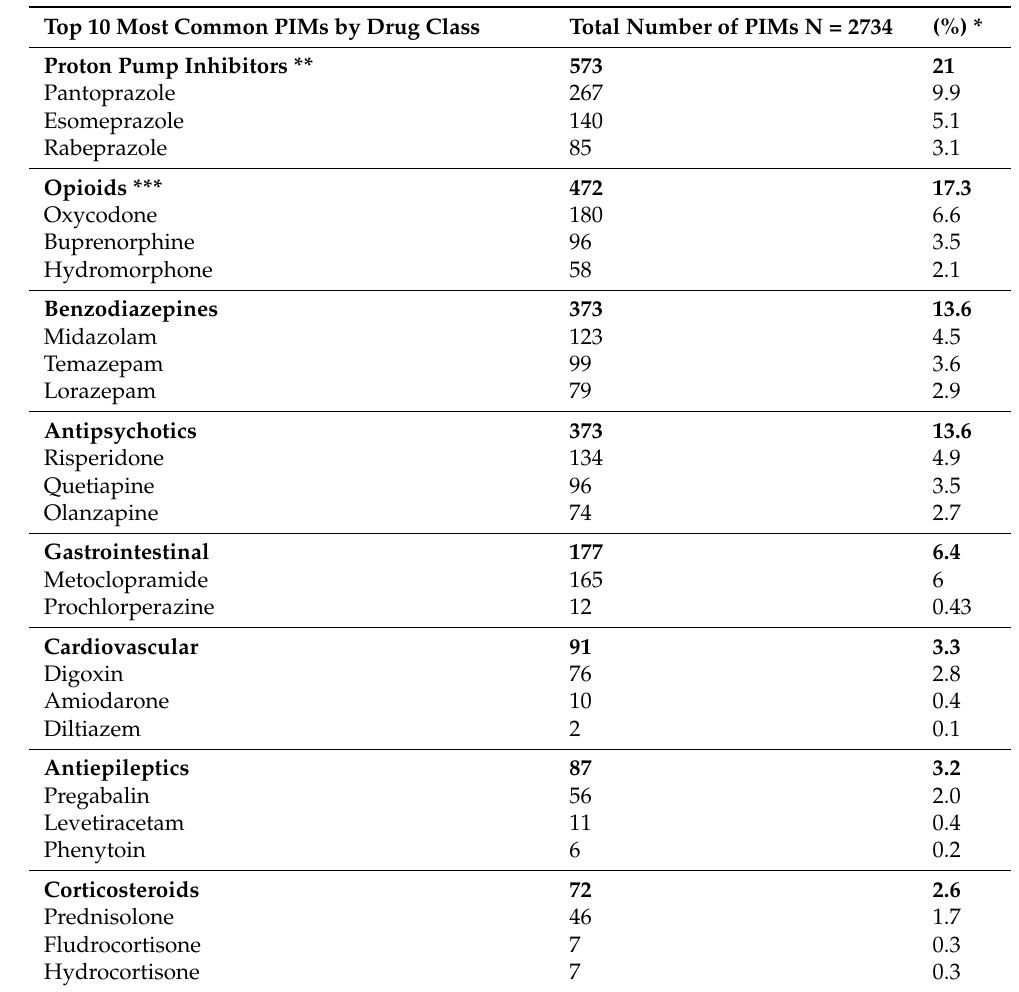
Table 3. Most commonly prescribed Potentially Inappropriate Medications